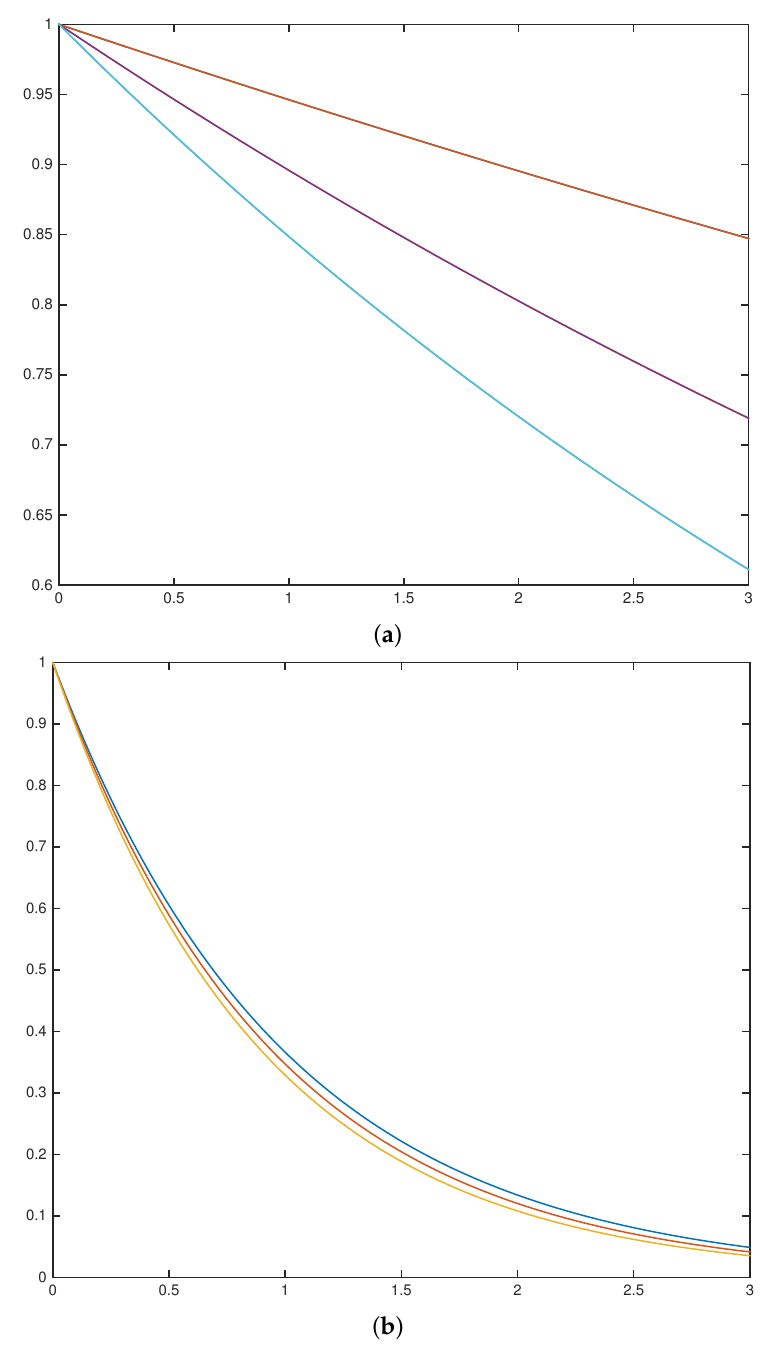
Figure 1. The option price φ 0 ( x ) , 0 ≤ x ≤ 3 for the interest rates r = 0.05/0.10/0.15 (from top to bottom): ( a ) in the symmetric case, c 0 = c 1 = 1, λ 0 = λ 1 = 1, b 0 = b 1 = 1, (here φ 0 = φ 1 ); ( b ) in the case c 0 = 1, c 1 = 0.5, λ 0 = 1, λ 1 = 4, b 0 = 1, b 1 = 0.1